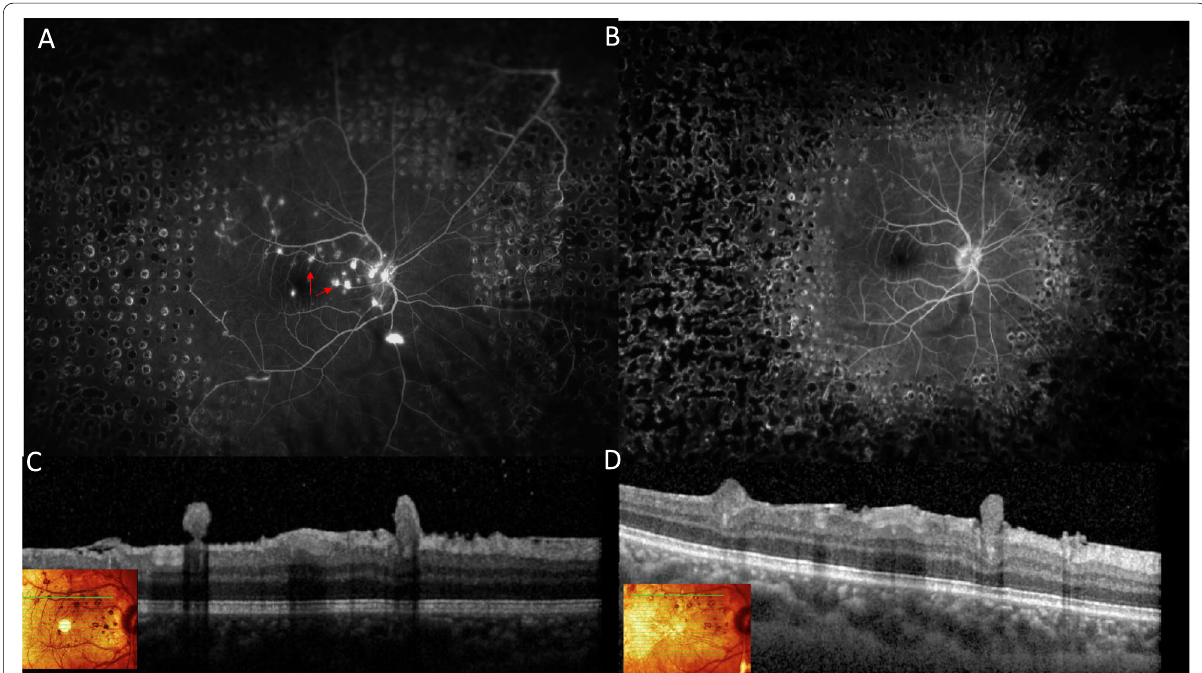
Fig. 4 Ultra‑widefield late‑frame FA of the right eye ( A ) showing scatter laser photocoagulation marks to the nonperfused retinal zones with regression of NVD and NVE. Note the persistence of ERNs (red arrows). Following more extensive PRP, fluorescein leakage from the ERNs halted ( B ). Corresponding OCT ( D ) showing shrinkage in lesions’ size as compared to ( C )